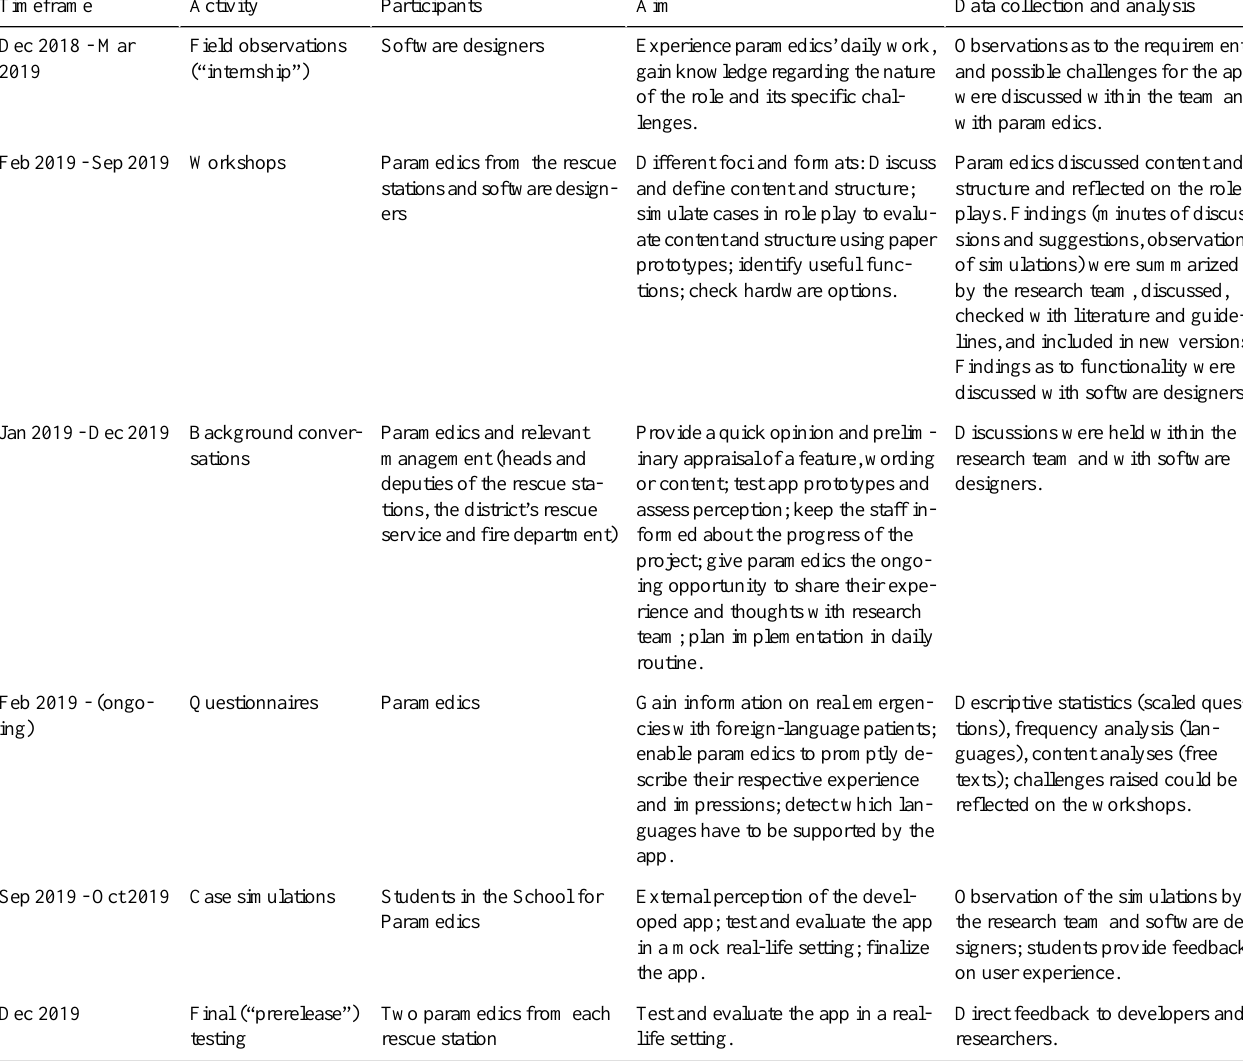
Table 1. Overview of the techniques used for app